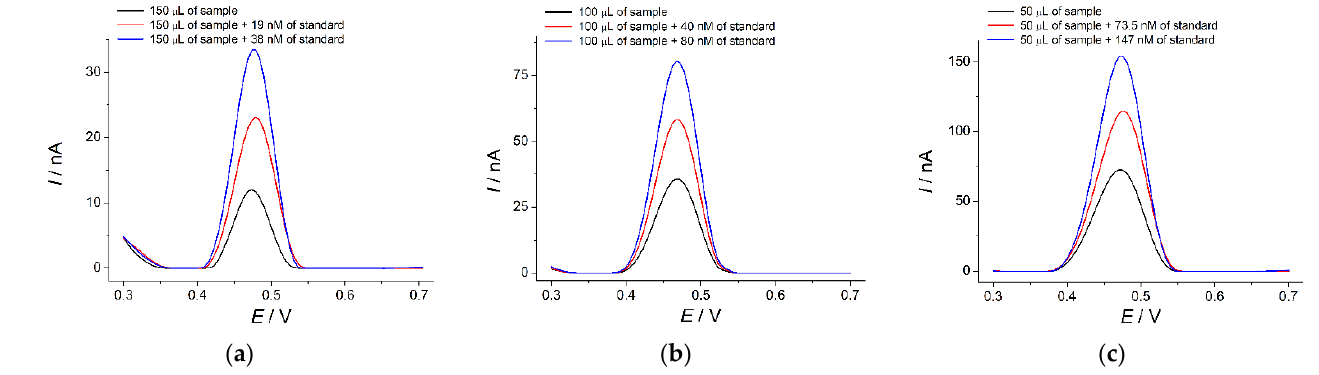
Figure 11. Baseline-corrected differential pulse voltammograms of pharmaceutical dosage forms in the absence and in the presence of indigo carmine additions at the SeO 2 –CPB/GCE in phosphate buffer pH 5.0: ( a ) vitamin tablets; ( b ) lozenges for symptomatic local treatment of the mouth and throat; ( c ) capsules shell of non-steroidal anti-inflammatory drug. Pulse width is 0.10 V, pulse height is 0.025 s, and potential scan rate is 10 mV s − 1 . Table 4. Indigo carmine recovery in pharmaceutical dosage forms ( n = 5; p = 0.95).